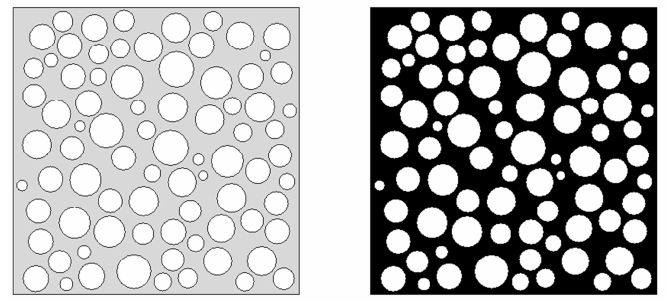
Figure 1. Structure diagram of porous aluminum alloy and image after binarization process.